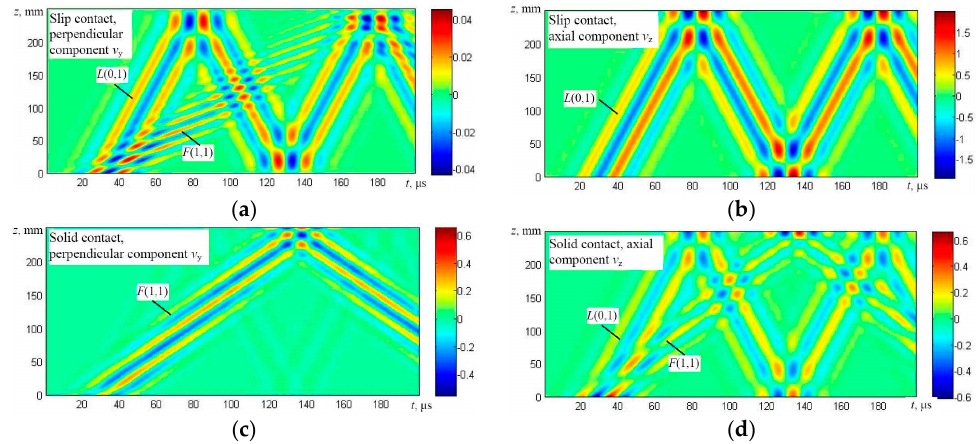
Figure 7. The B-scan images of the particle velocity along the first line of monitoring (the upper surface of the first wire) in the case of the edge type excitation: particle velocity components v y perpendicular to the axis of the wire ( a ) and v z (longitudinal-axial) ( b ) in the case of a slip contact and particle velocity components v y perpendicular to the axis of the wire ( c ) and v z (longitudinal-axial) ( d ) in the case of a solid contact between the neighboring wires.